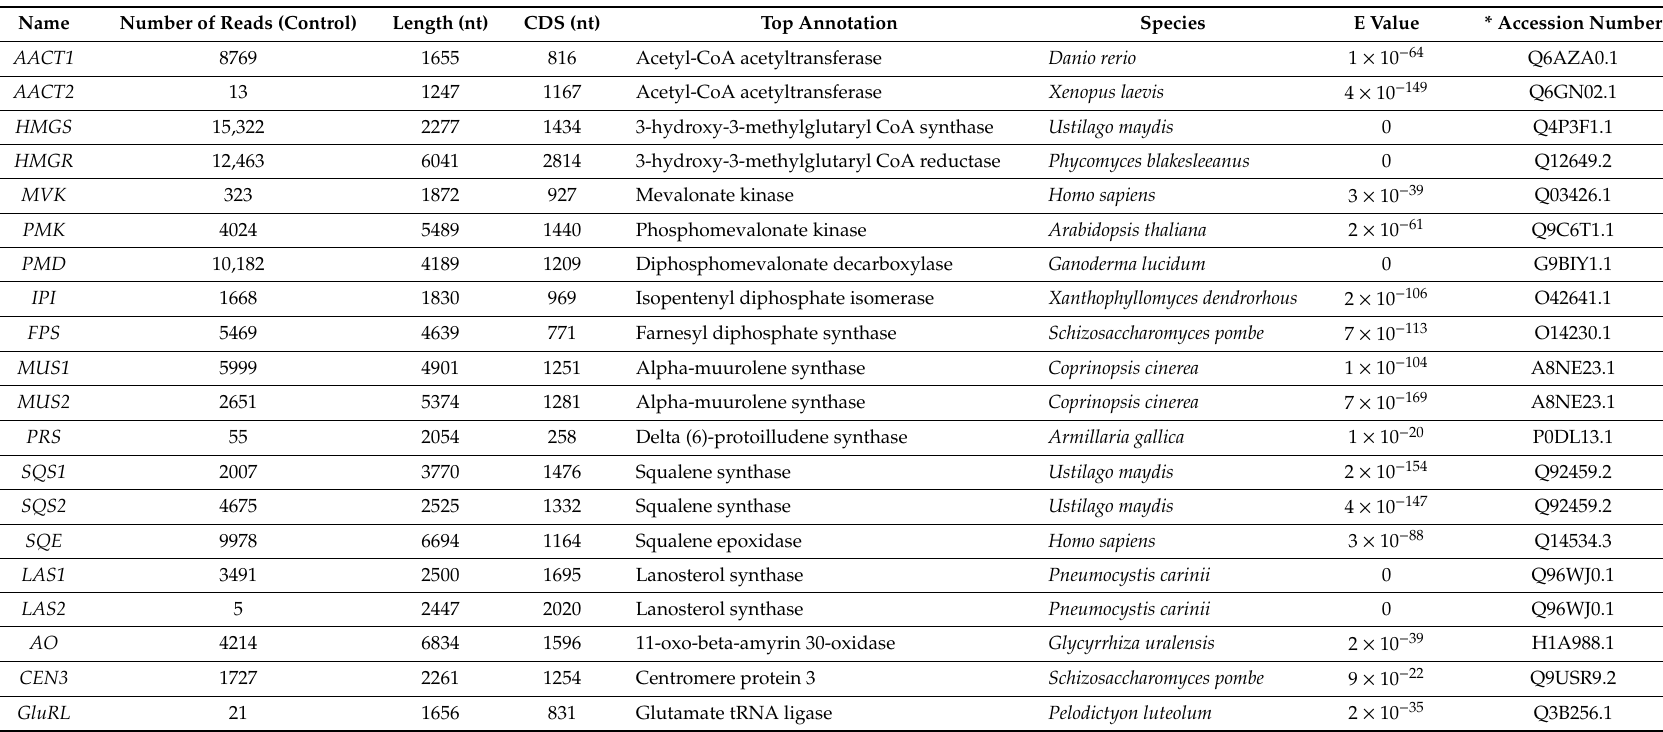
Table 2. Summary of the coding DNA sequence (CDS) of biosynthetic gene transcripts identified from the I. obliquus transcriptome known to be involved in terpenoid metabolism. All transcripts were deposited in the publicly available Genbank sequence database with the corresponding accession numbers listed in the material and methods section. * Accession number to UniprotKB /